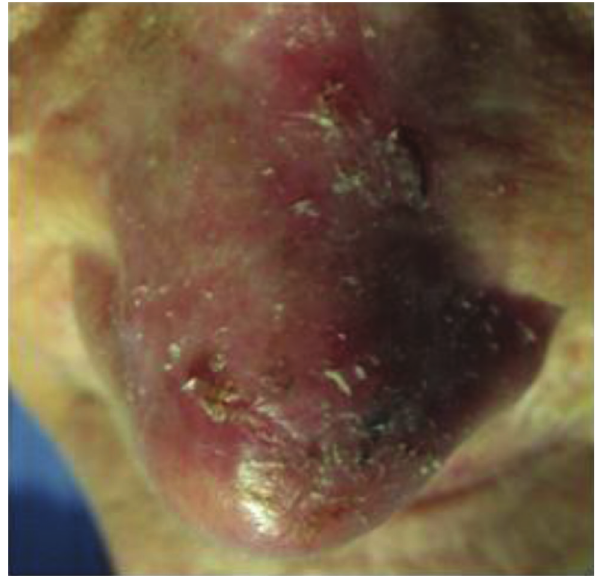
Figure 1 - Superficial basal cell carcinoma of the nose.